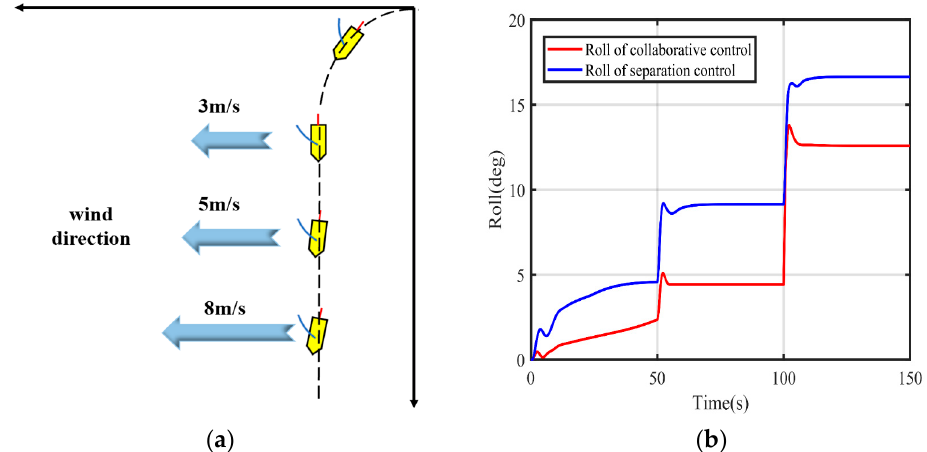
Figure 4. ( a ) Schematic diagram of sidewind navigation; ( b ) Comparison curves of roll angle for